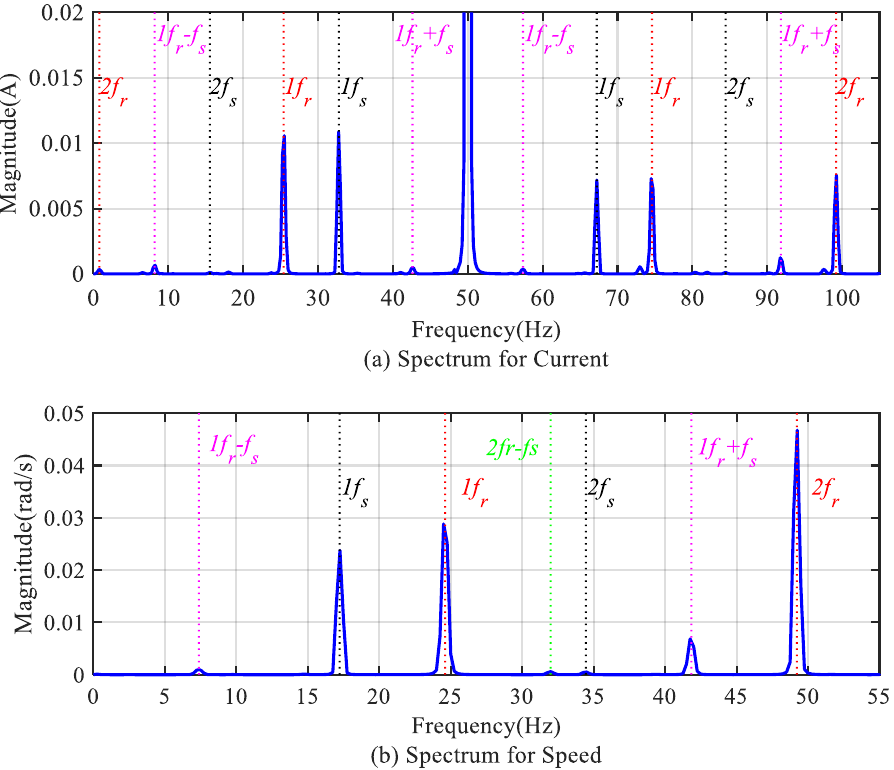
Figure 9. Spectra of current and speed (motor shaft eccentricity and belt’s transverse vibration ).